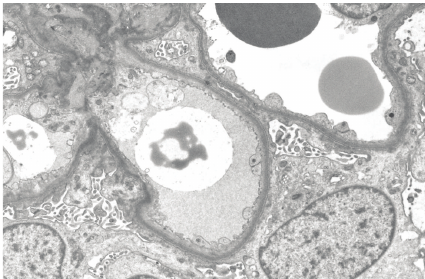
Figure2:Electronmicrograph( × 1100).TheseEMappearanceswere consistent with early recurrent FSGS. The presence of neutrophils in tubules raised a possibility of ascending bacterial urinary tract